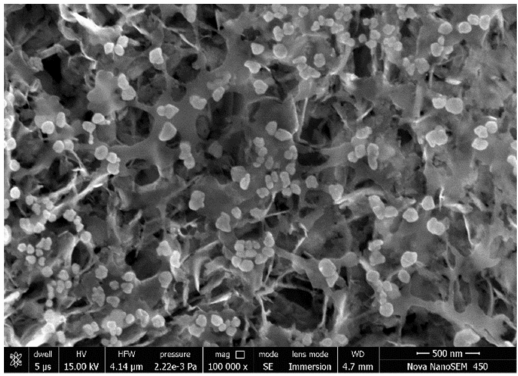
Figure 1. Scanning electron microscopy (SEM) of [Cu(12-crown-4) 5 (H 2 O) 6 ]I 6 · 2I 2